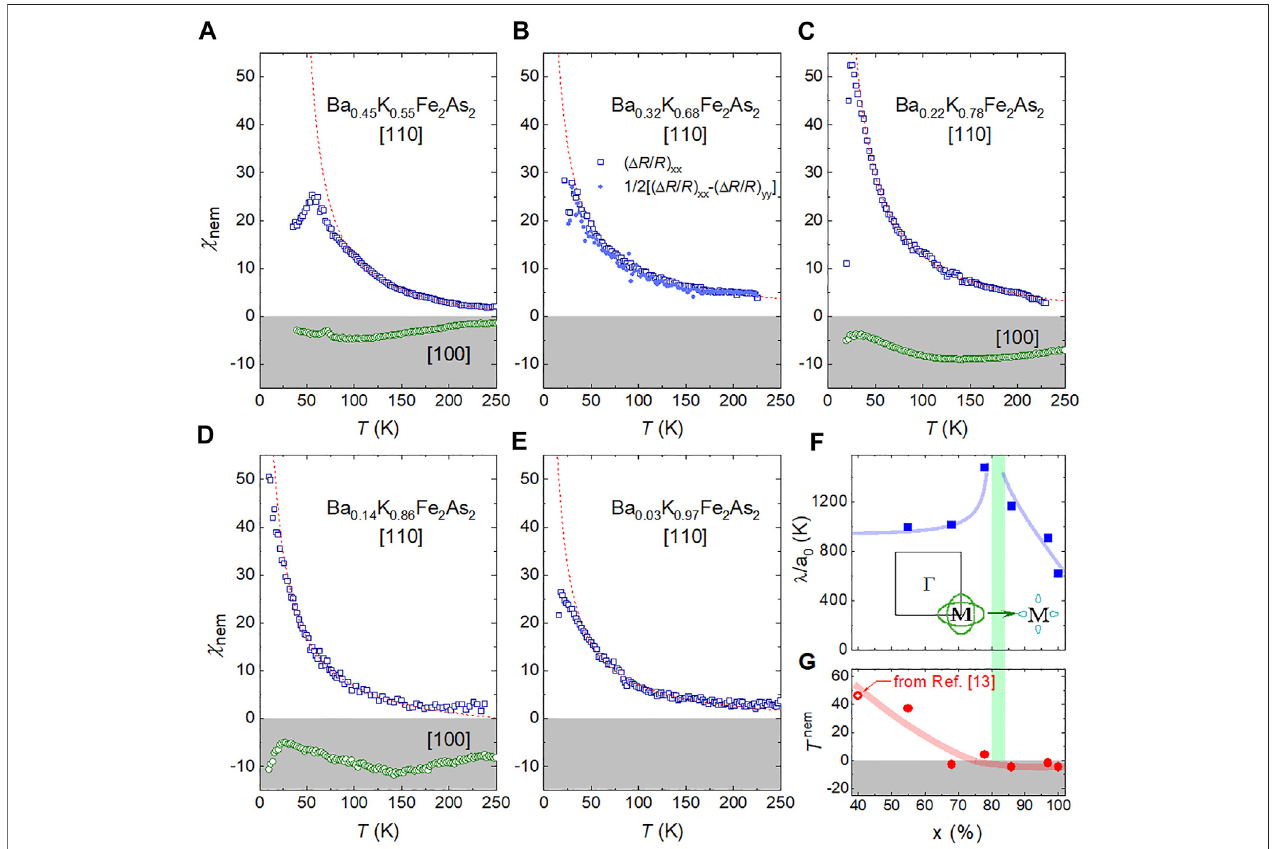
FIGURE 3 | Doping evolution of the elastoresistance in overdoped Ba χ er measured along the [110] direction is presented in the upper panels for 1 − x K x Fe 2 As 2 . Ba 1 − x K x Fe 2 As 2 single crystals with (A) x = 0.55, (B) x = 0.68, (C) x = 0.78, (D) x = 0.86, and (E) x = 0.97. The red dashed lines are CW- fi t to the data. χ er was also measuredalongthe[100]directionforthreeofthesamples.Thedataarepresentedinthelowerpanelsof (A) and (C,D) .Inpanel (B) , χ er extractedbyusingboth( Δ R / R ) xx and ( Δ R / R ) yy ( fi lledlightblue circles)and ( Δ R / R ) xx (openbluesquares)showsindistinguishableresults.Adopingdependenceofthe fi tparametersisdisplayedin (F) λ / a (G) T nem ofthe[110] χ er [ 110 ] data.Thethicklinesareaguidetotheeye.ALifshitztransitionaround x =0.8ishighlightedbythegreenbar.Holepocketsaroundthe 0 and M point of the Brillouin zone transform into electron lobes across the Lifshitz point [2]. T nem at x = 0.4 is extracted from Ref.